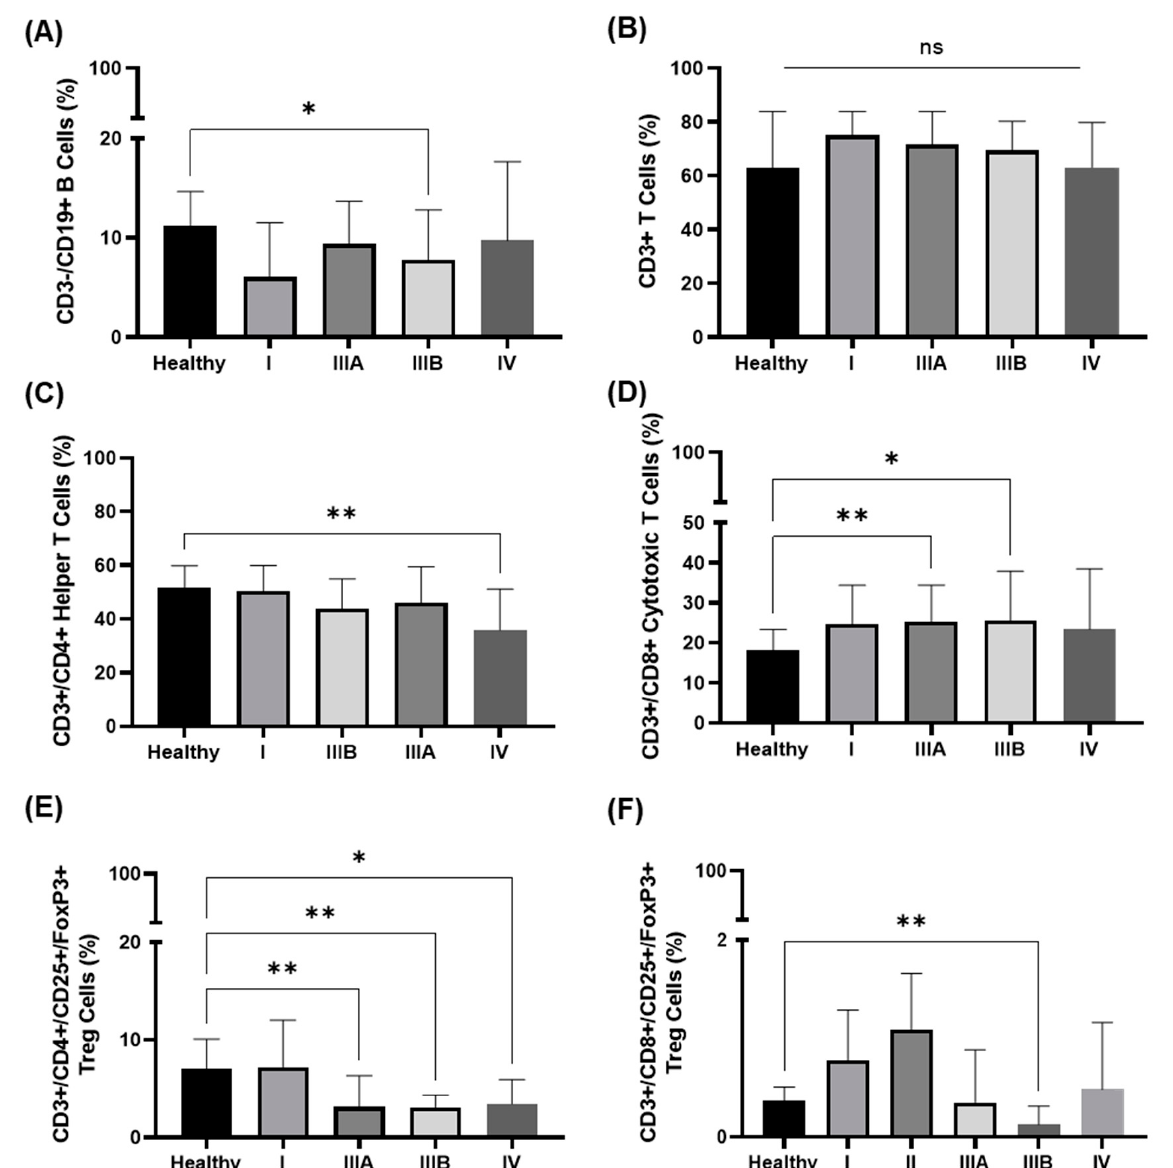
Figure 3. Frequency of B and T cell subsets in peripheral blood of healthy volunteers vs. NSCLC patients as determined by multiparameter flow cytometry. ( A ) The proportion of CD3+/CD19+ B cells in healthy volunteers is significantly higher than in NSCLC patients in UICC stage IIIB. ( B ) The proportion of CD3+ T cells in healthy volunteers is not significantly different to that of NSCLC patients in all different UICC stages. ( C ) With increasing UICC stages, the proportion of CD4+ T helper cells gradually decreases and reaches statistical significance in UICC stage IV. ( D ) With increasing UICC stages, the proportion of CD8+ T cytotoxic cells gradually increases and reaches statistical significance in UICC stages IIIA/B. ( E ) The proportion of CD4+ T regulatory cells in healthy volunteers are significantly higher than in NSCLC patients in all UICC stages ( n = 107), apart from UICC stage I ( n = 6). ( F ) The proportion of CD8+ T regulatory cells are significantly higher in healthy volunteers than in NSCLC patients in UICC stages IIIB. Statistically significant differences were * p < 0.05, ** p <